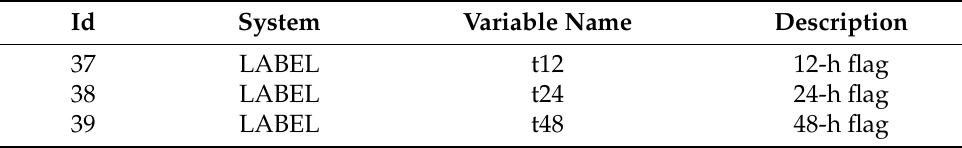
Table 2. Load Cycle: NEW ATTRIBUTES